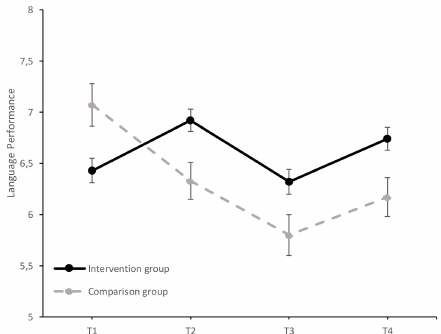
Figure 4. Evolution of the average LP scores ( ± SEM) in the intervention and comparison groups over time (T1 = baseline; T2 = at the end of the first year of intervention; T3 = follow-up after the first year of intervention; T4 = at the end of the second year of